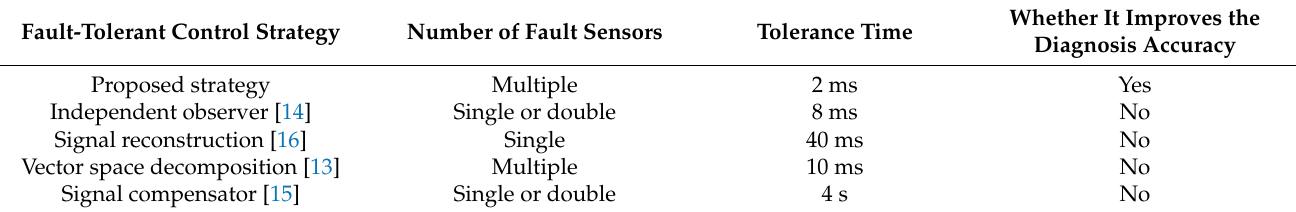
Table 4. Comparison of fault-tolerant control strategy.